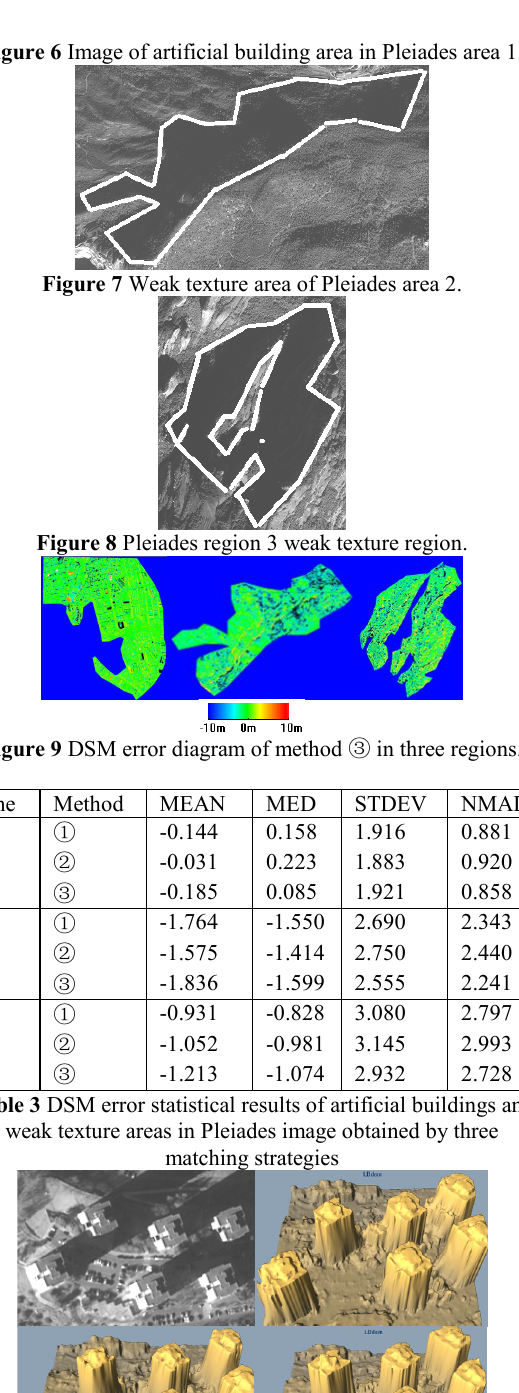
Figure 6 Image of artificial building area in Pleiades area 1.